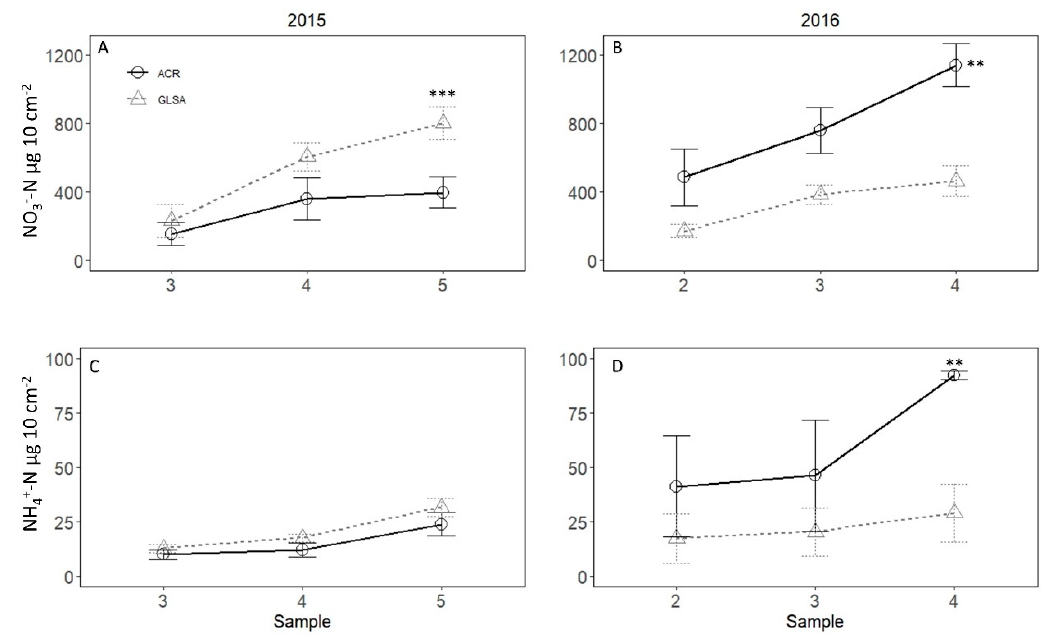
Figure 3. Average cumulative nitrate (NO 3 − -N) supply from fields with annual crop rotations (ACR) and following a 3-year grassland set-aside (GLSA) during the 2015 growing season ( A ); during the 2016 growing season ( B ); cumulative ammonium (NH 4+ -N) supply during the 2015 growing season ( C ); and during the 2016 season ( D ). Error bars represent standard error of the mean (n = 4). Significant differences are indicated by ** ( p < 0.01), and *** ( p < 0.001).